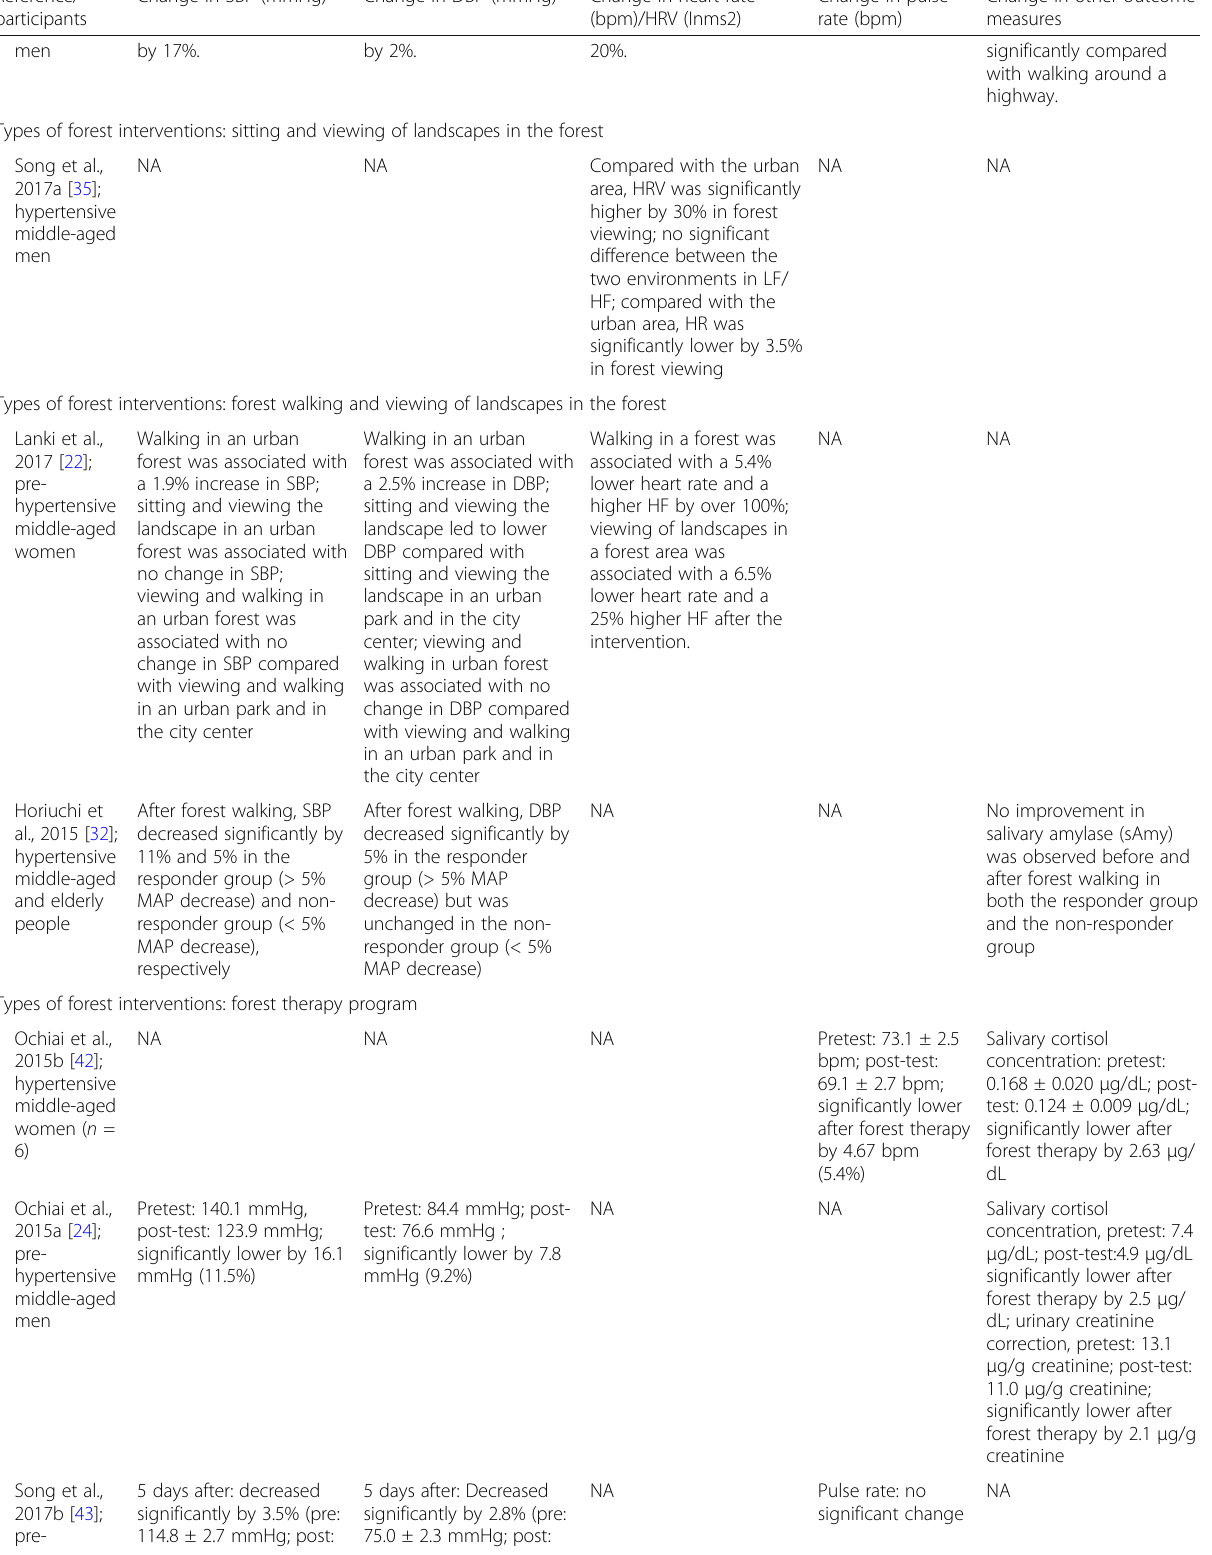
Table 2 Summary of the physiological outcome measures of the included studies (Continued) Reference/ Change in SBP (mmHg) Change in DBP (mmHg) Change in heart rate participants men by 17%. by 2%. 20%. significantly compared